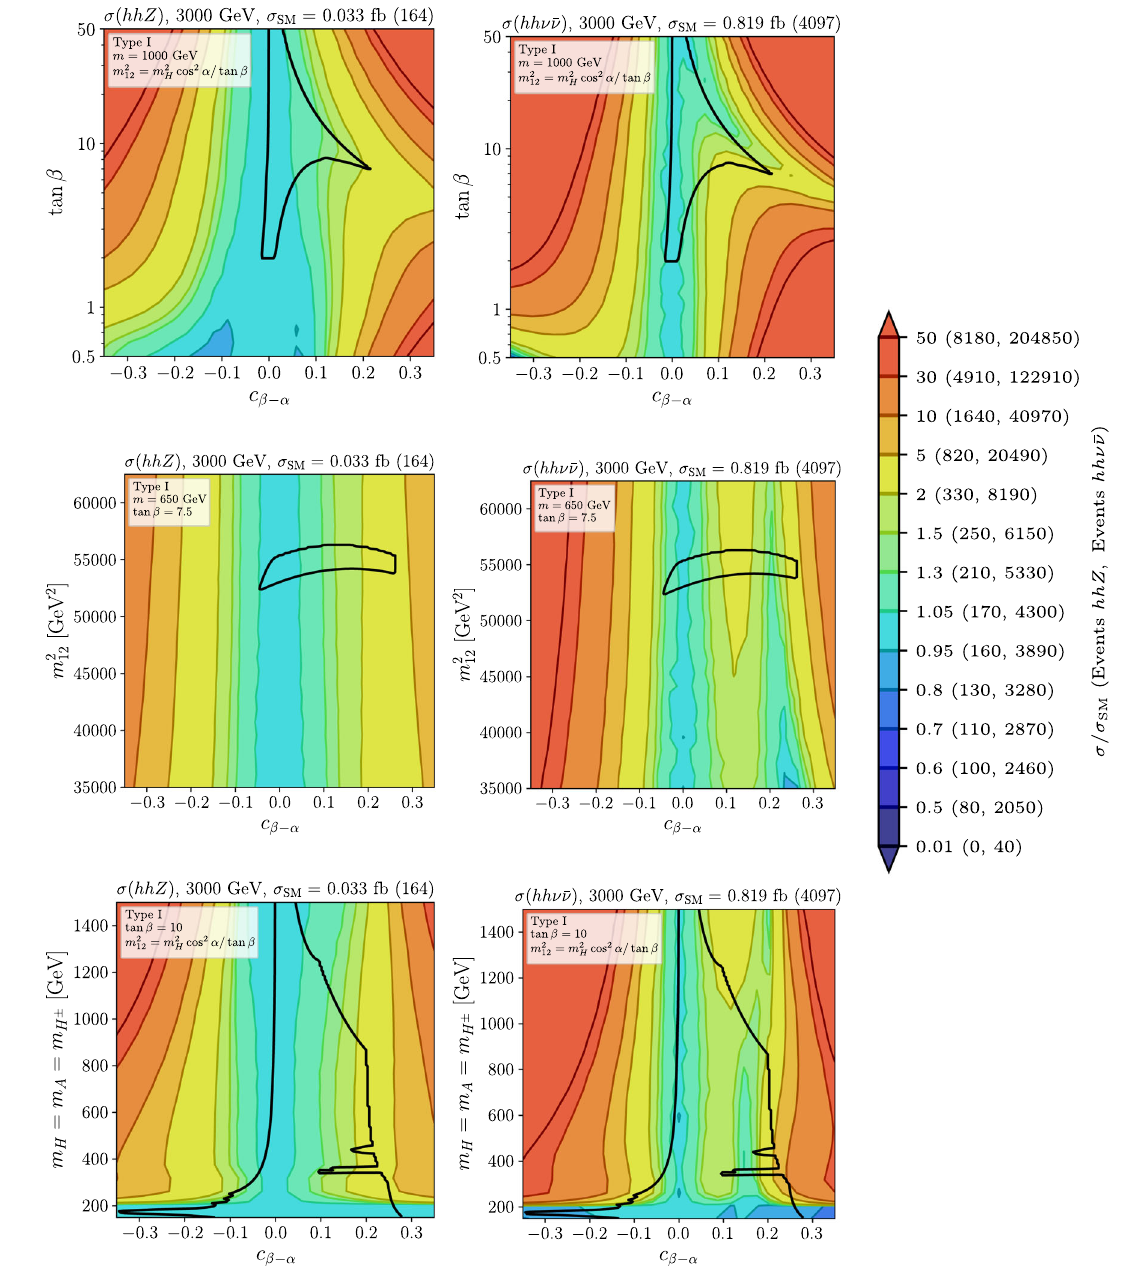
√ s = 3000 GeV for the benchmark planes 1-3 (top to bottom). The